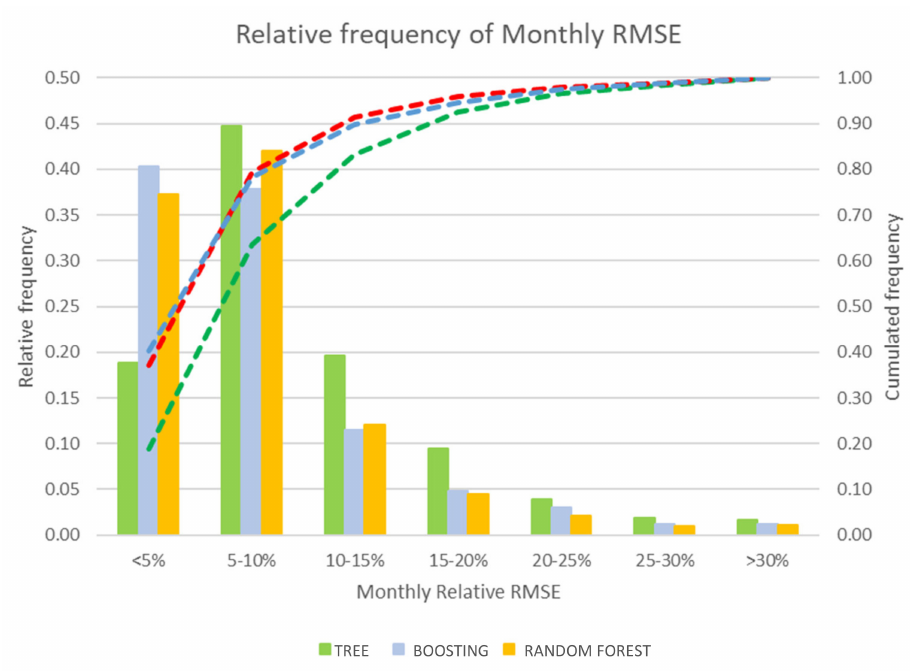
Figure 11. Monthly relative RMSE for the best of each model.